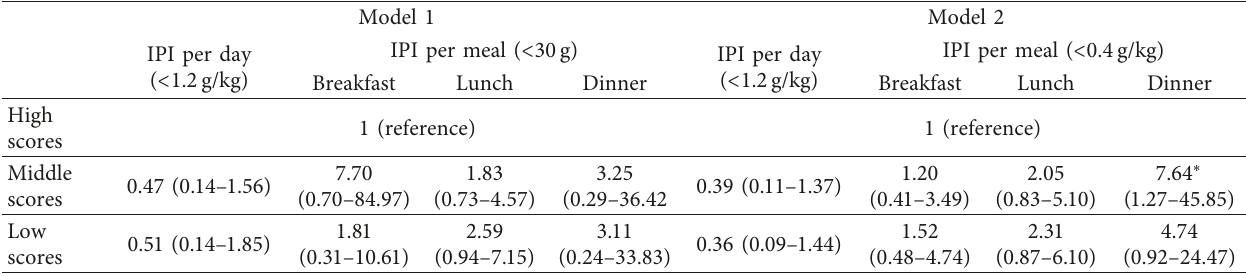
Table 4: Risk of impaired functionality for instrumental activities of daily living (IADL) related to the inadequate protein intake per day and per meal in middle to older aged Mexican adults ( n � 190).